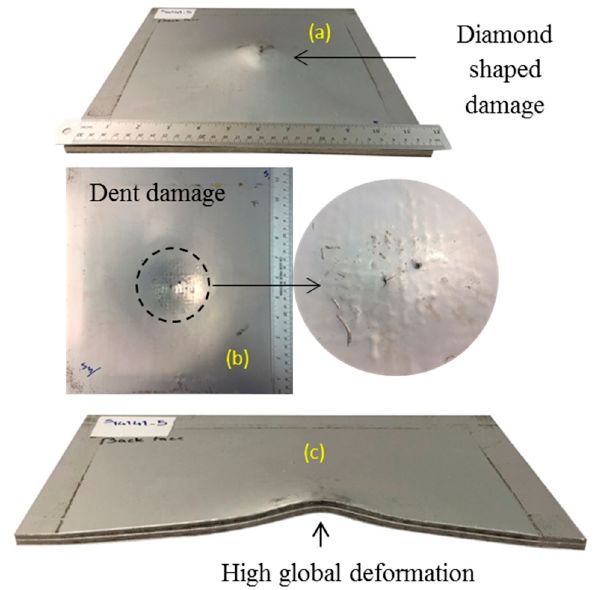
Figure 11. Sample code S14141-5 subjected to impulse 31.2 N.s ( a ) back face, ( b ) front face, ( c ) cross-section.